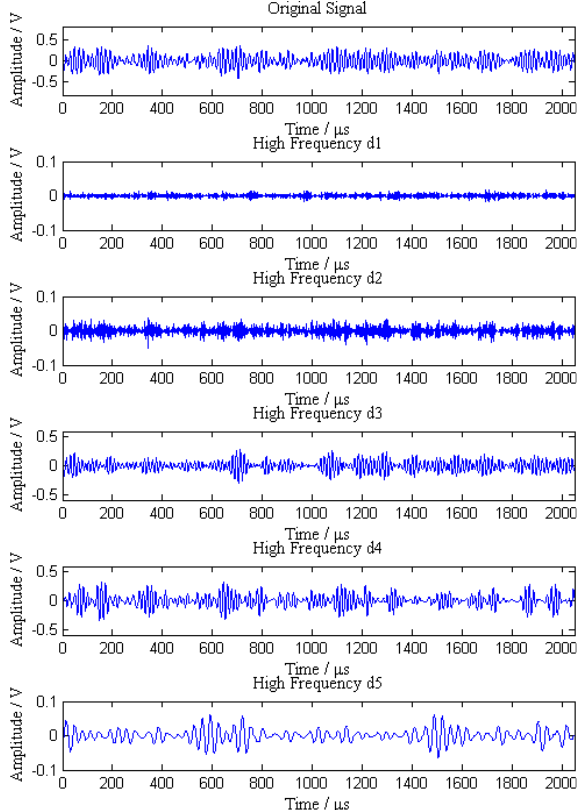
Figure 11. Signal decomposition of node 5.